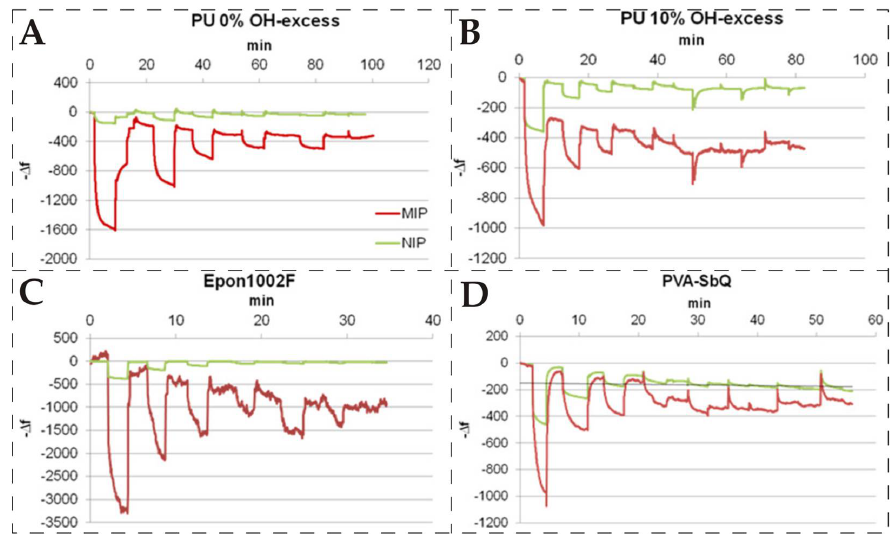
Figure 4. QCM sensor responses of four different MIP layers imprinted with same strains of E. coli ; ( A ) shows the sensor response of polyurethane layer (0% OH-excess group); ( B ) polyurethane layer (10% OH-excess) group; ( C ) represents sensor effects for Epon 1002F and finally ( D ) shows the response for PVA-SbQ. All sensor layers were exposed to same series of different E. coli concentrations i.e., 7.3, 3.6, 1.8, 0.9, 0.7, and 0.4 × 10 7 CFU/mL, reproduced with permission from [110].